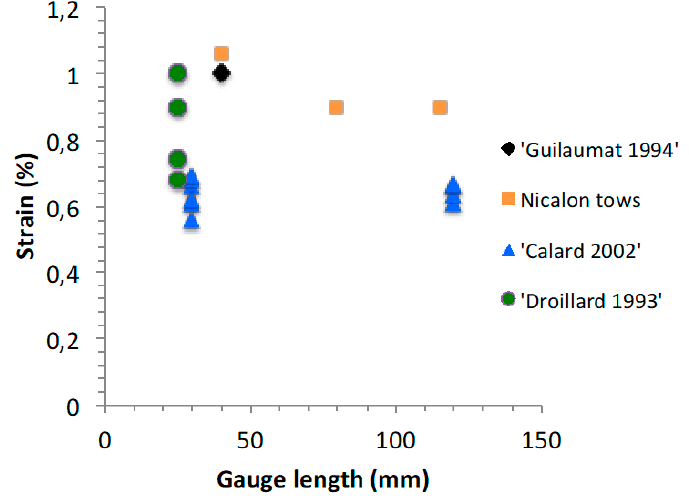
Figure 17. Comparison of strains at maximum force measured on the Nicalon SiC tows and strain-to-failure measured on 2D Nicalon SiC/SiC specimens with various gauge lengths [53,54,62,63].